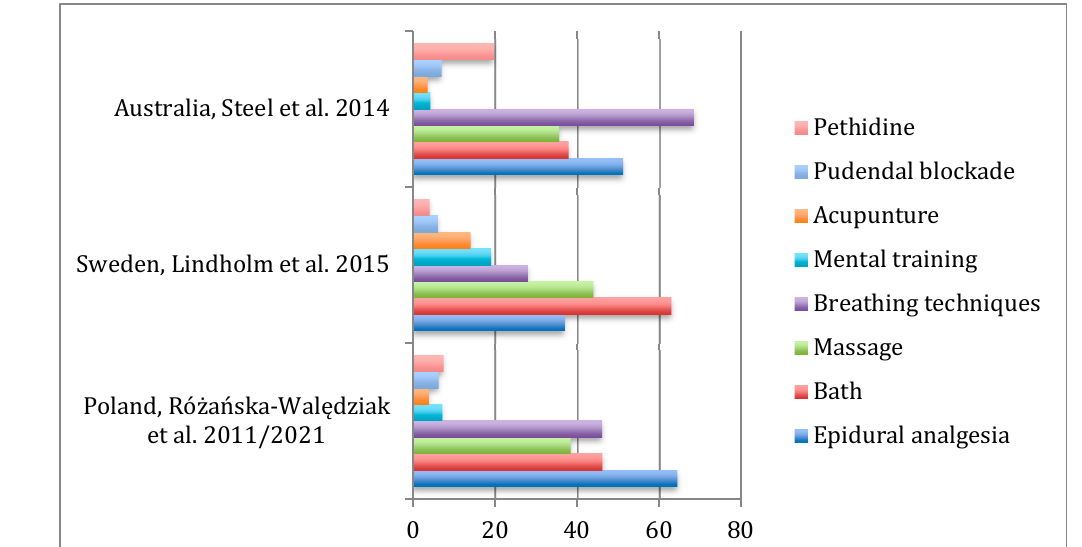
Figure 1. Distribution of preference for pain relief methods in labor.